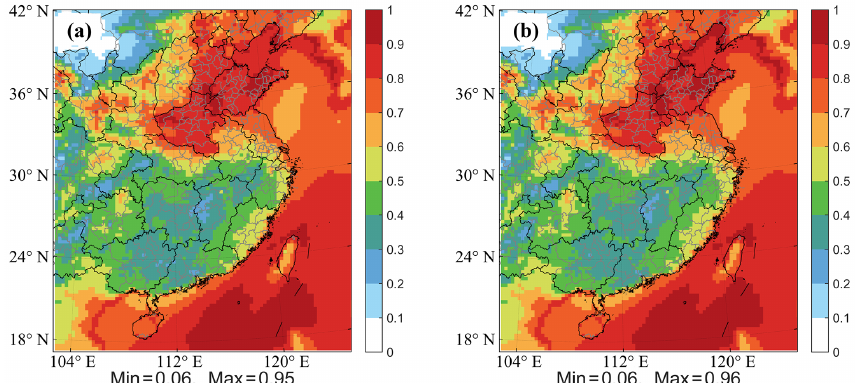
Figure 5. Spatial distribution of the monthly mean of chlorine partitioning ( [ Cl − ] /( [ Cl − ]+[ HCl ] ) ) in the Base (a) and NoCl (b) experiment.